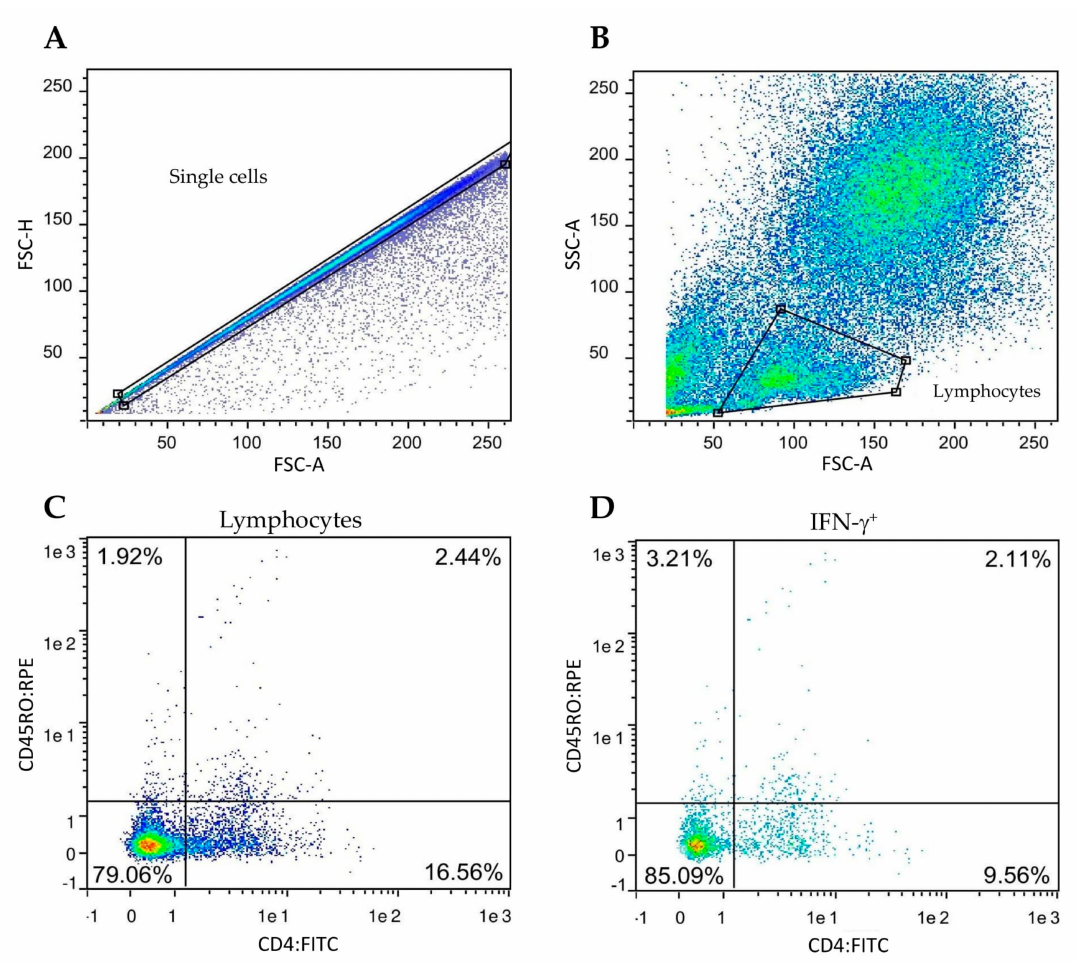
Figure 1. Gating strategy for the determination of frequency of the IFN- γ positive lymphocyte subsets. Peripheral blood mononuclear cells (PBMC) from all goats were cultured in the presence of M. bovis tuberculin (PPD-B). ( A , B ) Singlet lymphocytes were identified based on the degree of cellular di ff erentiation determined by forward scatter (FSC) and side scatter (SCC). ( C ) Representative frequencies of the CD4 / CD45RO cell populations. ( D ) Representative frequencies of intracellular IFN- γ staining of cells gated from prelabelled CD4 + CD45RO +